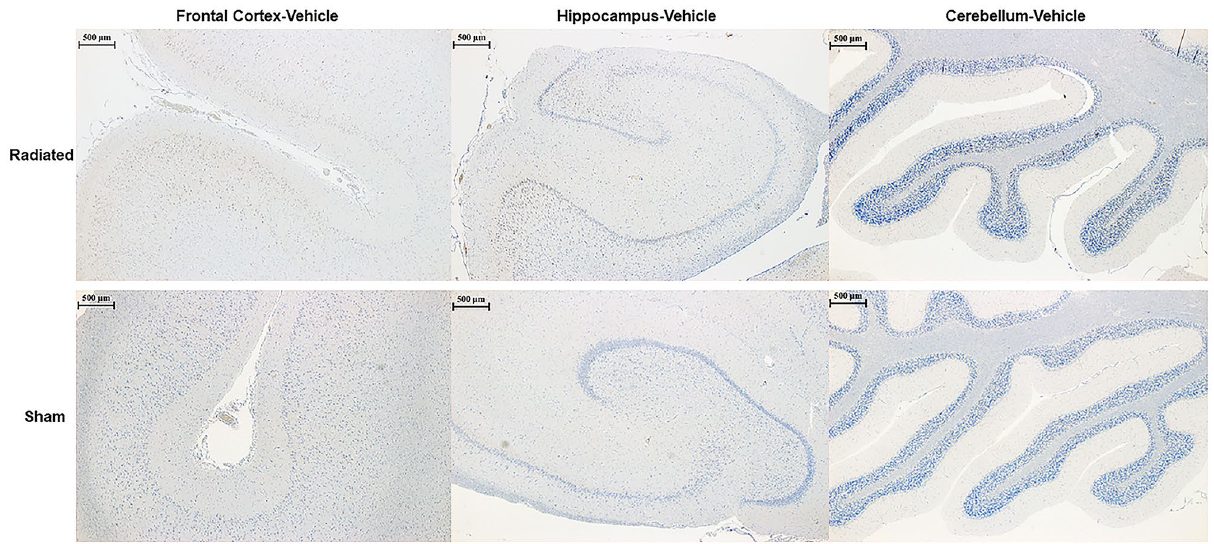
Figure 5. CP13 Immunohistochemistry across Different Regions of Swine Brains after 4 weeks following low-dose post-radiation. The figure shows Frontal Cortex, Hippocampus and Cerebellar Cortex of a Radiated and a Sham vehicle treated animal immunostained for pTau using CP13 antibody. To notice, no differences were present at histological level between Radiated versus Sham animals across any of the anatomical region considered. The digital photographs were taken using a bright-light microscope (Zeiss ImagerA2) with a 20 × objective.